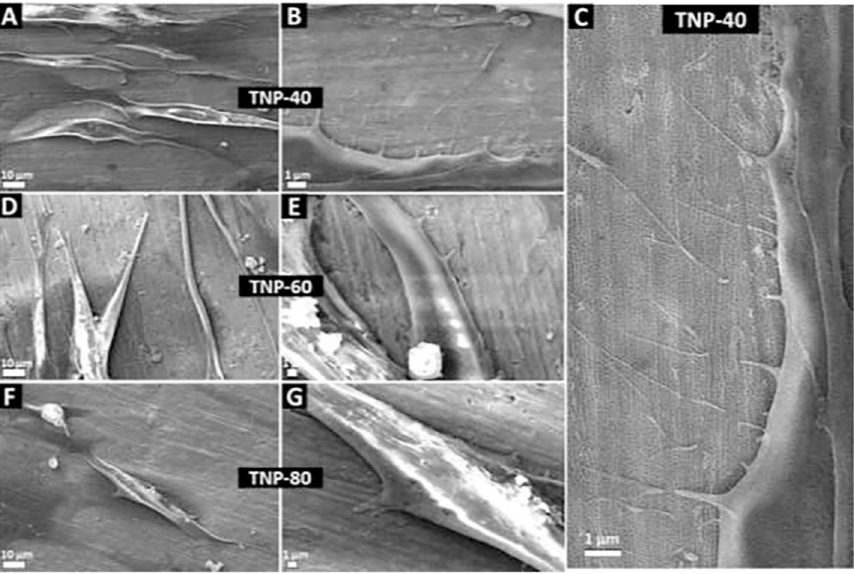
Figure 5. hGFs on TiO 2 surface with NP after 1 day, ( A – C ) TNP-40, ( D , E ) TNP-60, ( F , G ) TNP-80. Adapted with the permission from [5180781375259] [9].